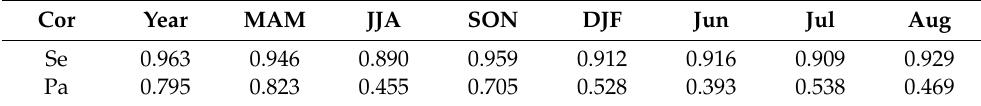
Table 4. Correlation coefficients of nighttime precipitation difference with nighttime precipitation Table 3. Correlation coefficients of precipitation difference with precipitation probability (Pp), af- intensity difference (Se) and nighttime precipitation frequency difference ternoon precipitation difference (Pa), nighttime precipitation difference (Pe), afternoon precipitation frequency difference (Ppa) and nighttime precipitation frequency difference (Ppe).